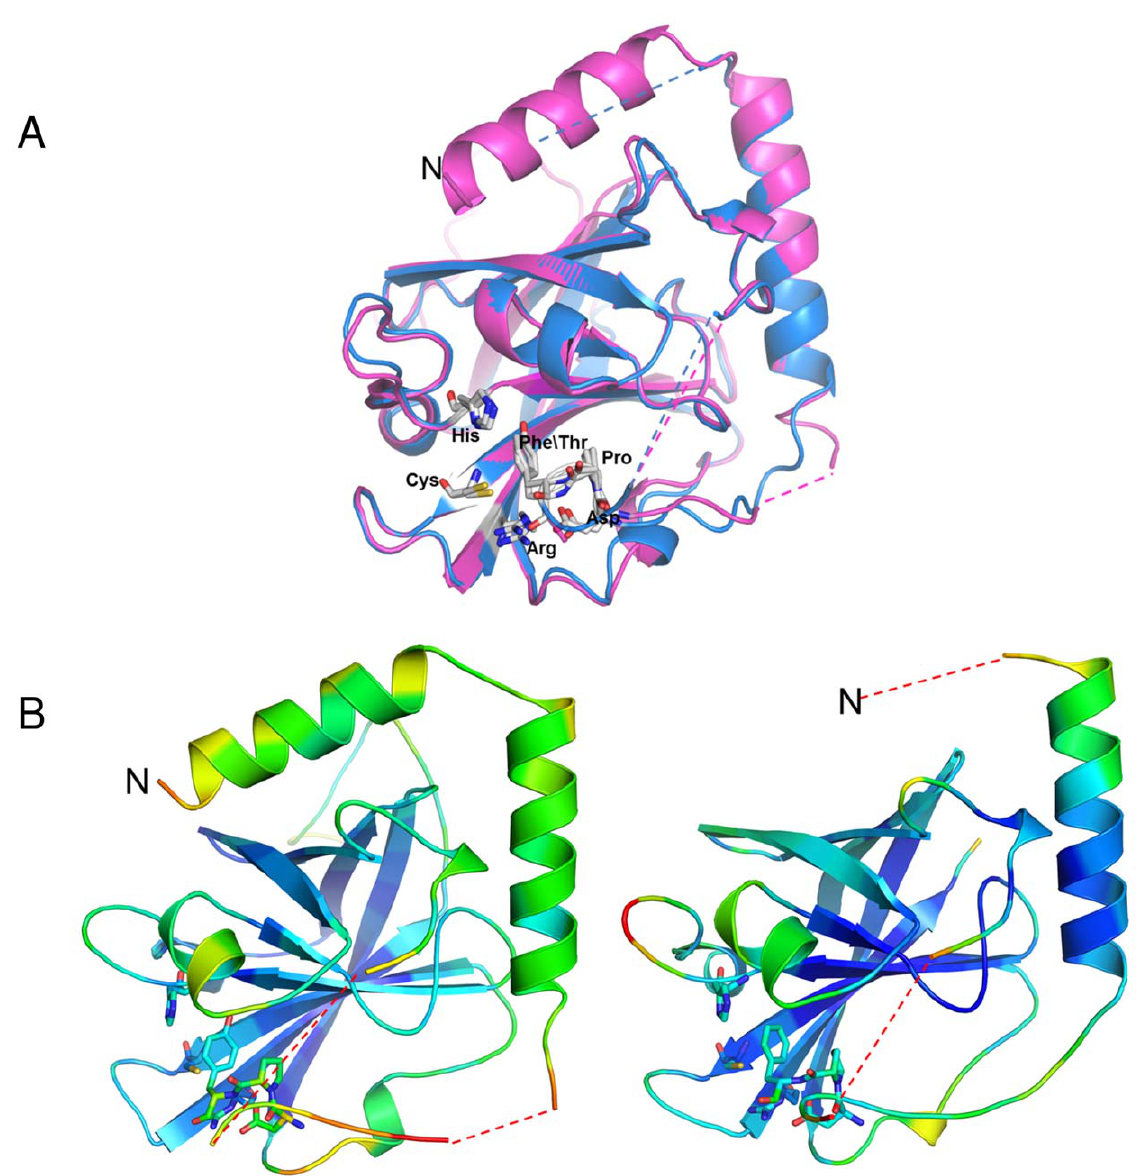
Figure 5. Structural analysis of GBS PI-1 SrtC enzymes. (A) Superposition of GBS PI-1 SrtC2 (in blue) with GBS SrtC1 (magenta). Residues forming the mobile lid (Asp90, Tyr92 in SrtC1 and Asp 84, Phe 86 in SrtC2) and the active site (H163, C225, R234 in SrtC1 and H156, C218, R227 in SrtC2) are shown as sticks. Localized lack of electron density in the loop regions of both structures suggests that the N-terminal region is flexible. (B) GBS PI-1 SrtC1 (left panel) and SrtC2 (right panel) ribbon diagrams colored according to the B-factor distribution, from low (blue) to high (red). The average residue B-factors range from 13.8 to 65.3 A˚2 in SrtC1 and from 19.2 to 63.1 A˚2 in SrtC2.